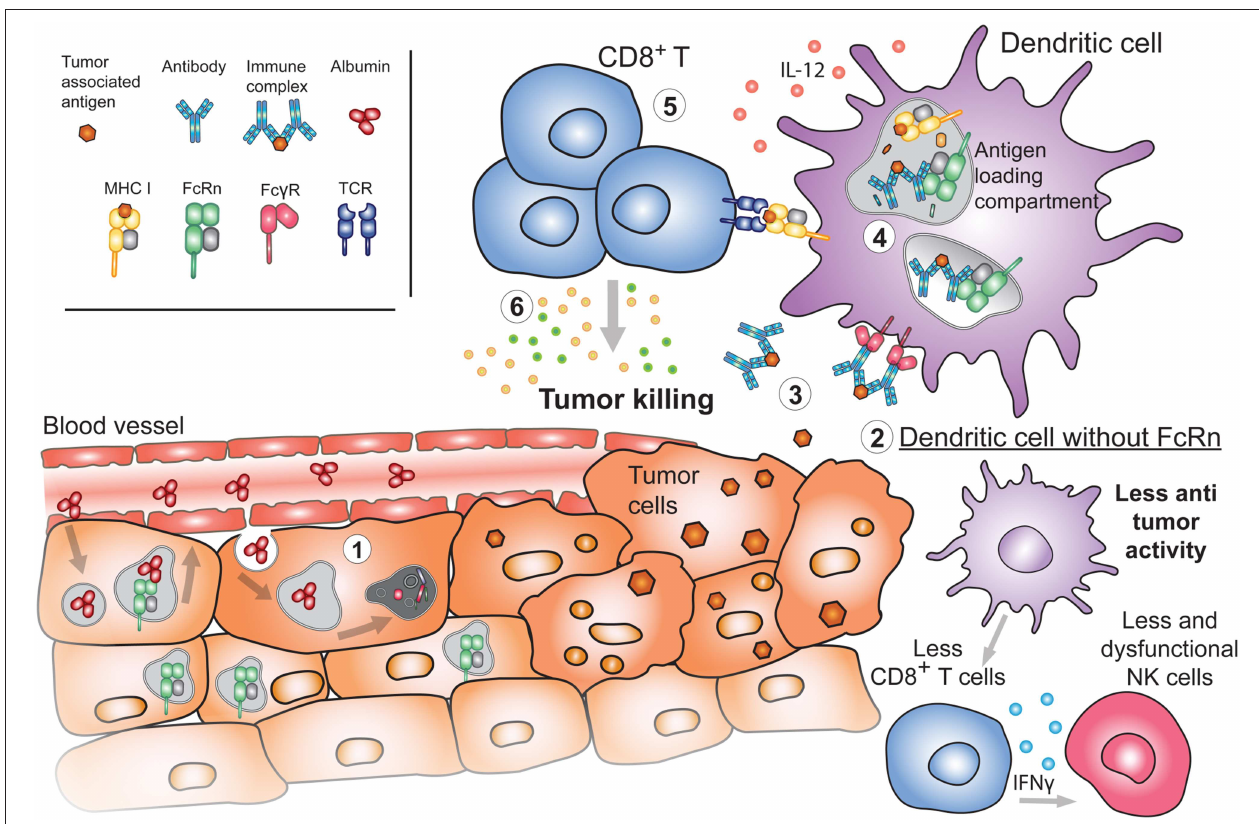
FIGURE 5 | Emerging roles of FcRn in cancer. (1) During the process of oncogenesis, cells can lose or downregulate FcRn expression. In these instances, tumor cells will be unable to recycle albumin upon its internalization. Albumin will instead be degraded, providing nutrients to the tumor and promoting tumor growth. (2) Absence of FcRn in APC may decrease the basal cytotoxic tone (such as IL-12 production) resulting in diminished numbers and function of either NK or CD8 + T cells in tissues, generating a tumor-prone environment. (3) Released tumor antigens can be bound by antibodies and internalized by APC through Fc γ Rs. Presence of FcRn in these cells is important for (4) the subsequent sorting and efficient processing of IgG IC in antigen loading compartments where tumor-derived peptides are loaded onto MHC I for cross-presentation to (5) cytotoxic CD8 + T cells. Activated tumor specific CD8 + T cells will (6) effectively target cancerous cells for